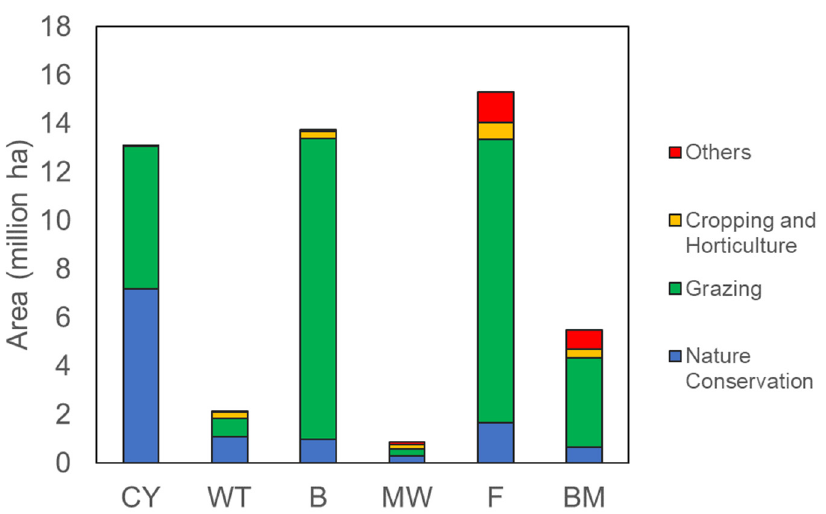
Figure 1. Total area and land use of NRM regions within the GBR catchments (CY = Cape York, WT = Wet Tropics, B = Burdekin, MW = Mackay Whitsunday, F = Fitzroy and BM = Burnett Mary). The sediment loads in the GBR is mainly sourced from areas dedicated to grazing. While this is the main activity for all 6 regions, locations with poor ground cover and for multi-crops are more susceptible to erosion, resulting in sediment runoff prior to the break of the wet season [10]. As per Table 1, the highest contributor of anthropogenic-derived